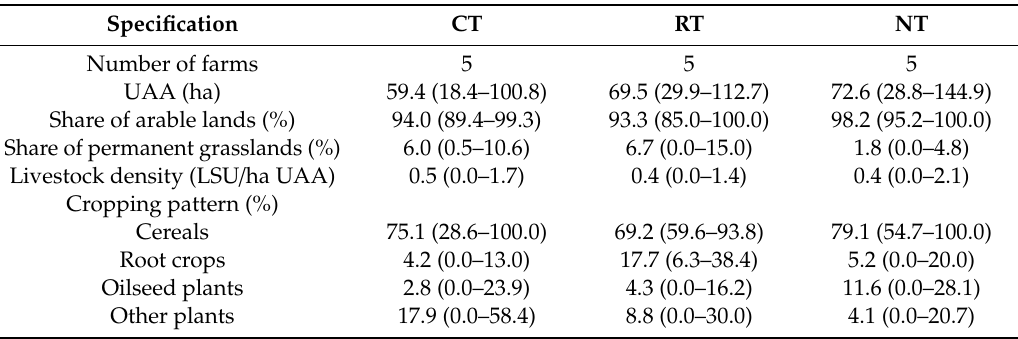
Table 1. Characteristics of studied farms representing grain maize production in conventional tillage (CT), reduced tillage (RT) and no-tillage (NT) systems (averages from the study years with min–max range in parentheses).